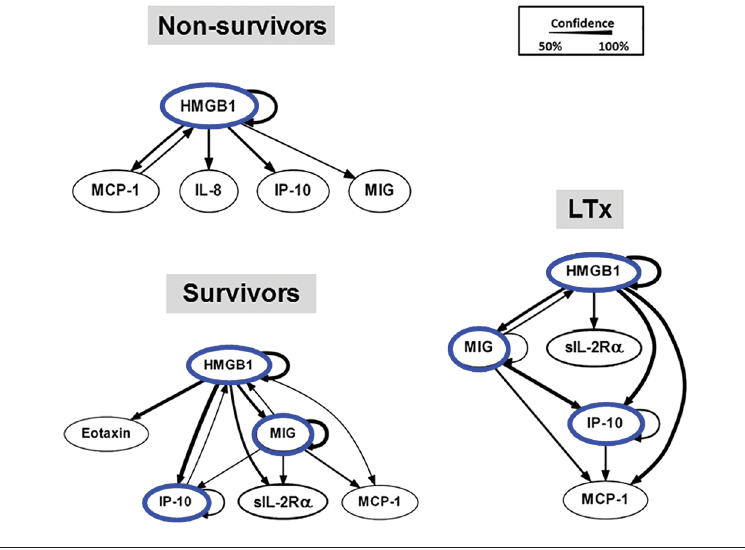
Figure 1. Dynamic Bayesian Network (DBN) analysis of circulating inflammatory mediators in PALF patients. Circulating inflammatory mediators in serum samples from PALF sponta- neous survivors (S, n = 61 patients), nonsurvivors (NS, n = 12 patients) and liver transplant recipients (LTx, n = 28 patients) were measured and DBN analysis was performed, as described in Materials and Methods. Inflammatory mediators are shown as nodes, and the arrows connecting them suggest an influence of one mediator on the one(s) it is con- nected to. The arrows do not distinguish positive from negative influences. Semicircular arrows suggest either positive or negative feedback of a given mediator on